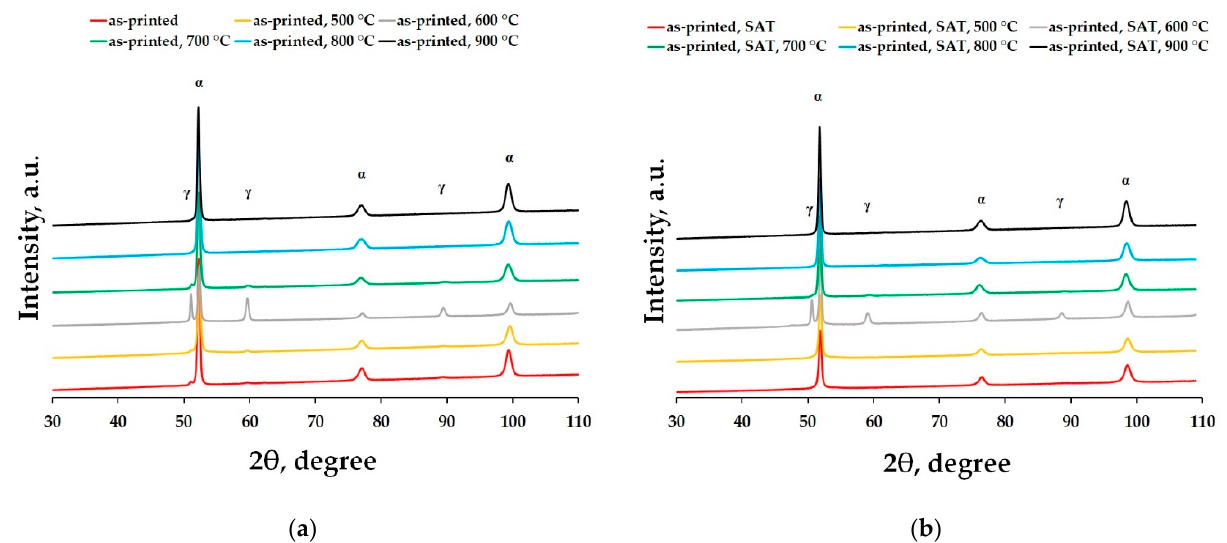
Figure 5. XRD patterns of the 1.2709 maraging steel depending on elevated temperatures: ( a ) as- printed; ( b ) as-heat-treated (SAT—solution annealing and aging treatment); holding time 2 h, water- cooling.